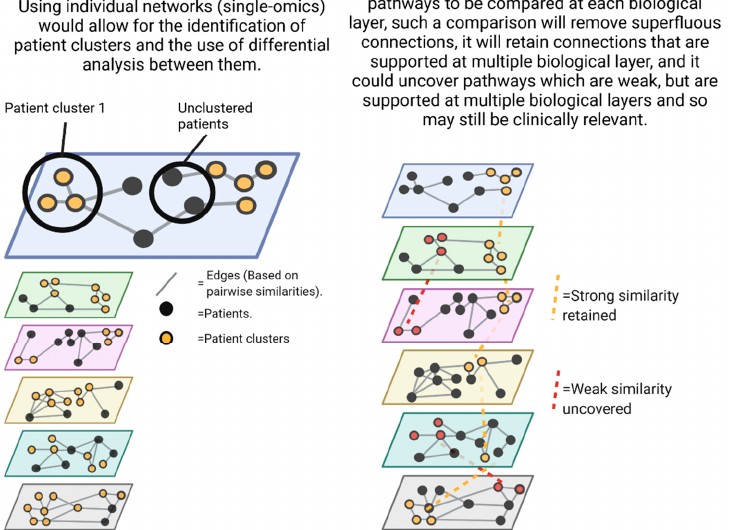
Figure 2. A highlight of the advantages that network analysis of multi-omic data provides, allowing us to not only remove false positives from our analysis, but simultaneously uncover false negatives that would otherwise remain unnoticed. (Created with